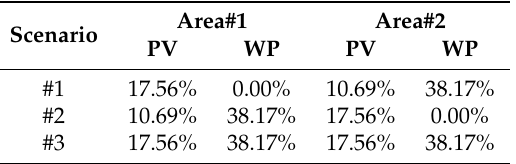
Table 11. CFs considered for the single snapshot approach, according to